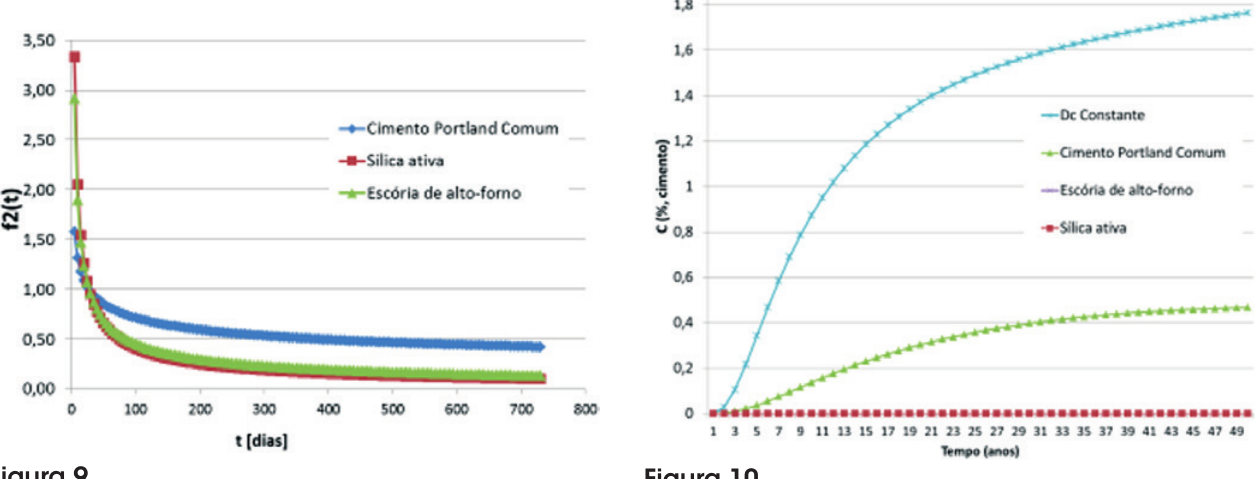
Variação da função multiplicativa f2 (t) ao longo de dois anos